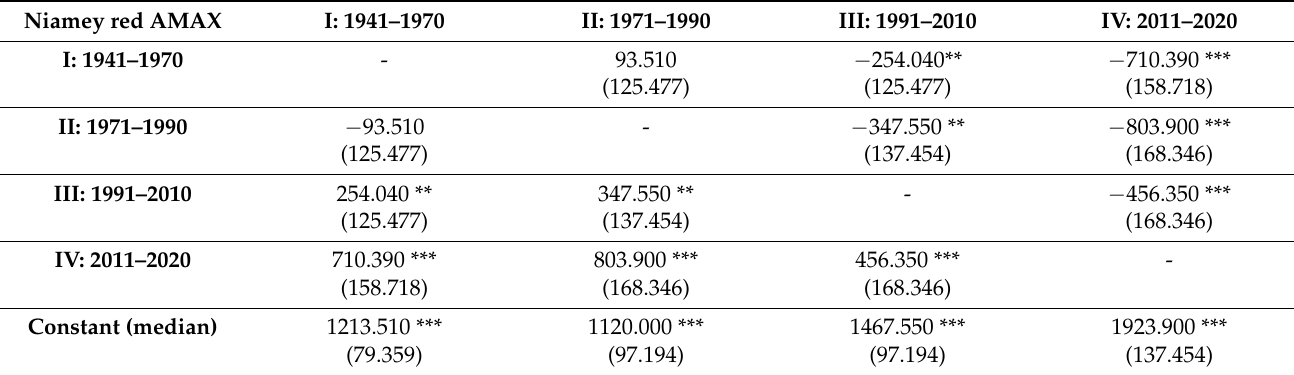
Table 8. Data series segmentation (fixed periods): Quantile regression of red AMAX in Niamey. Difference in medians among periods and standard errors (in parentheses). Significance of changes: *** p < 0.01, ** p < 0.05, * p < 0.1. Niamey red